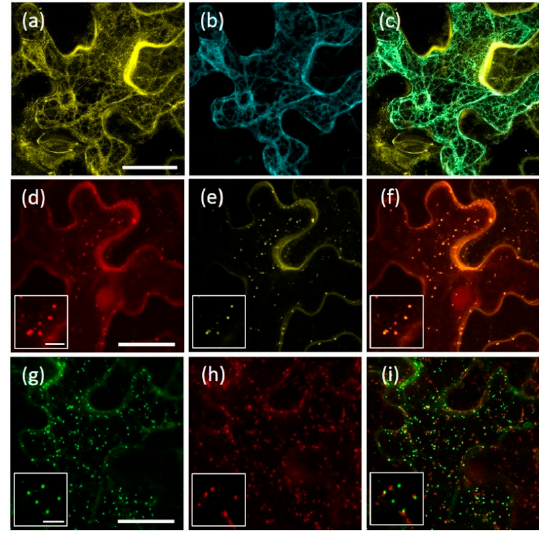
Figure 3. Localization of AtRMR1 and -2 in the endoplasmic reticulum (ER) and trans -Golgi network (TGN), respectively. Co-localization of AtRMR1-YFP with the ER marker p6-CFP ( a – c ); and co-localization of AtRMR2-RFP with the TGN marker Venus-SYP61 ( d – f ) or AtRMR2-GFP with the Golgi marker GONST1-RFP ( g – i ). YFP signal ( a ); CFP signal ( b ); RFP signal ( d , h ); Venus signal ( e ); GFP signal ( g ); and merged images ( c , f , i ). Stacked confocal images, excepted inserts ( d – i ; single images). Scale bars = 30 µm; and 5 µm (inserts).